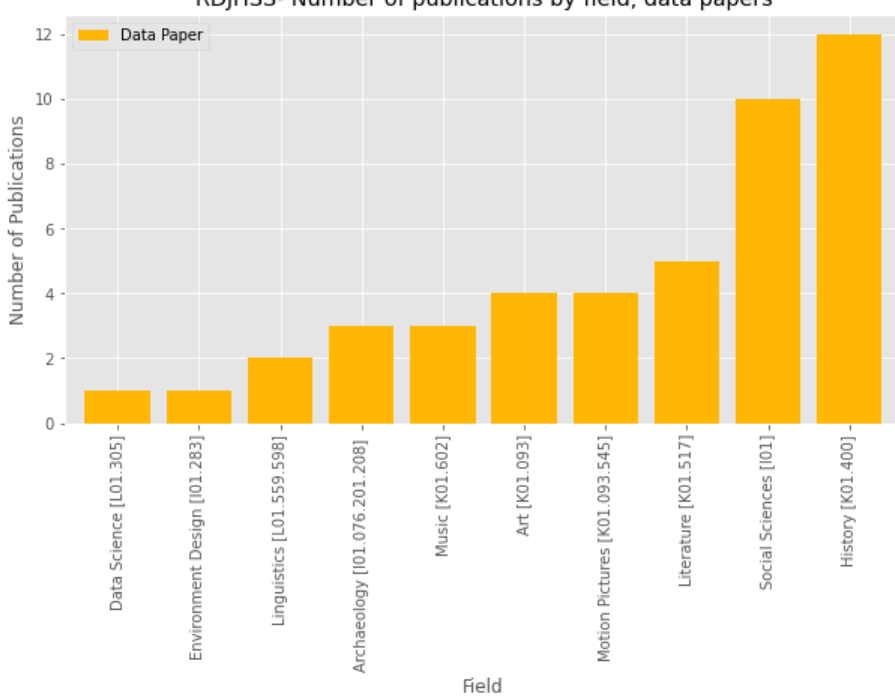
Figure A3. Numbers of publications by field represented as MeSH hierarchical codes in RDJ papers.